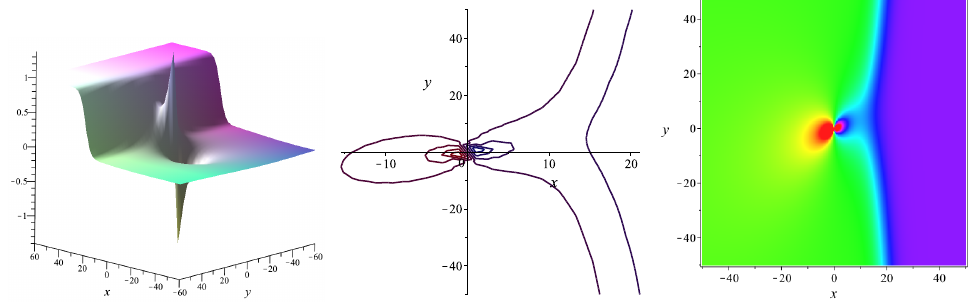
Figure 3. 3D plot, contour plot and density plot corresponding to f 5 ( x , y , z , t ) at times t = 0.